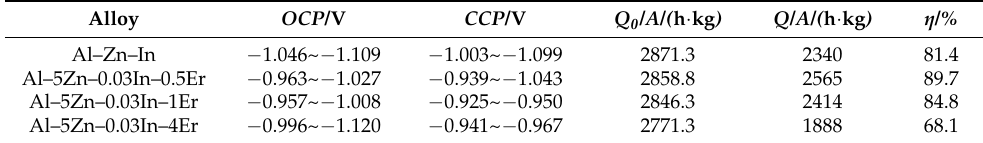
Table 4. Electrochemical properties of the Al–5Zn–0.03In– x Er